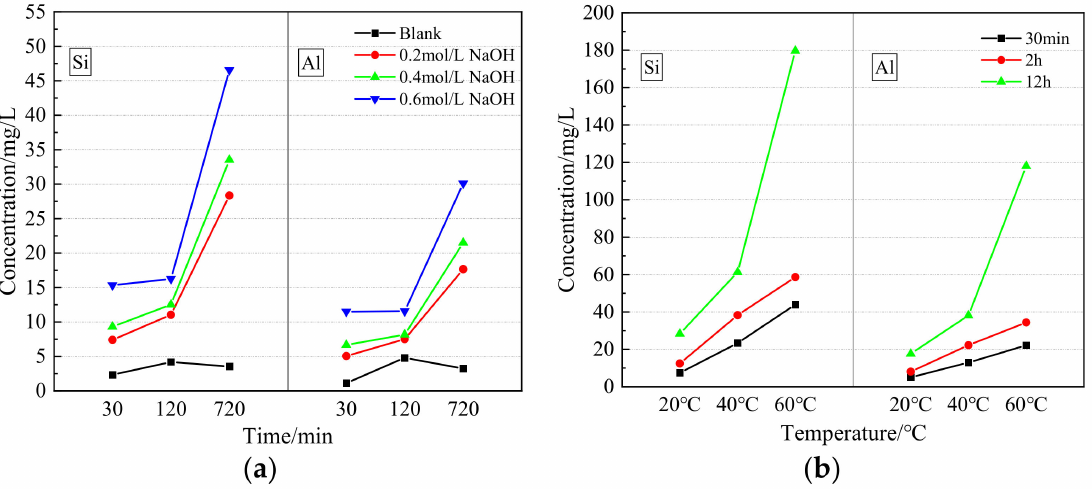
Figure 7. Si and Al dissolution characteristics of the GFS powder. ( a ) Dissolution of Si and Al in GFS powder at different temperatures, ( b ) Dissolution of Si and Al in GFS powder under different alkaline